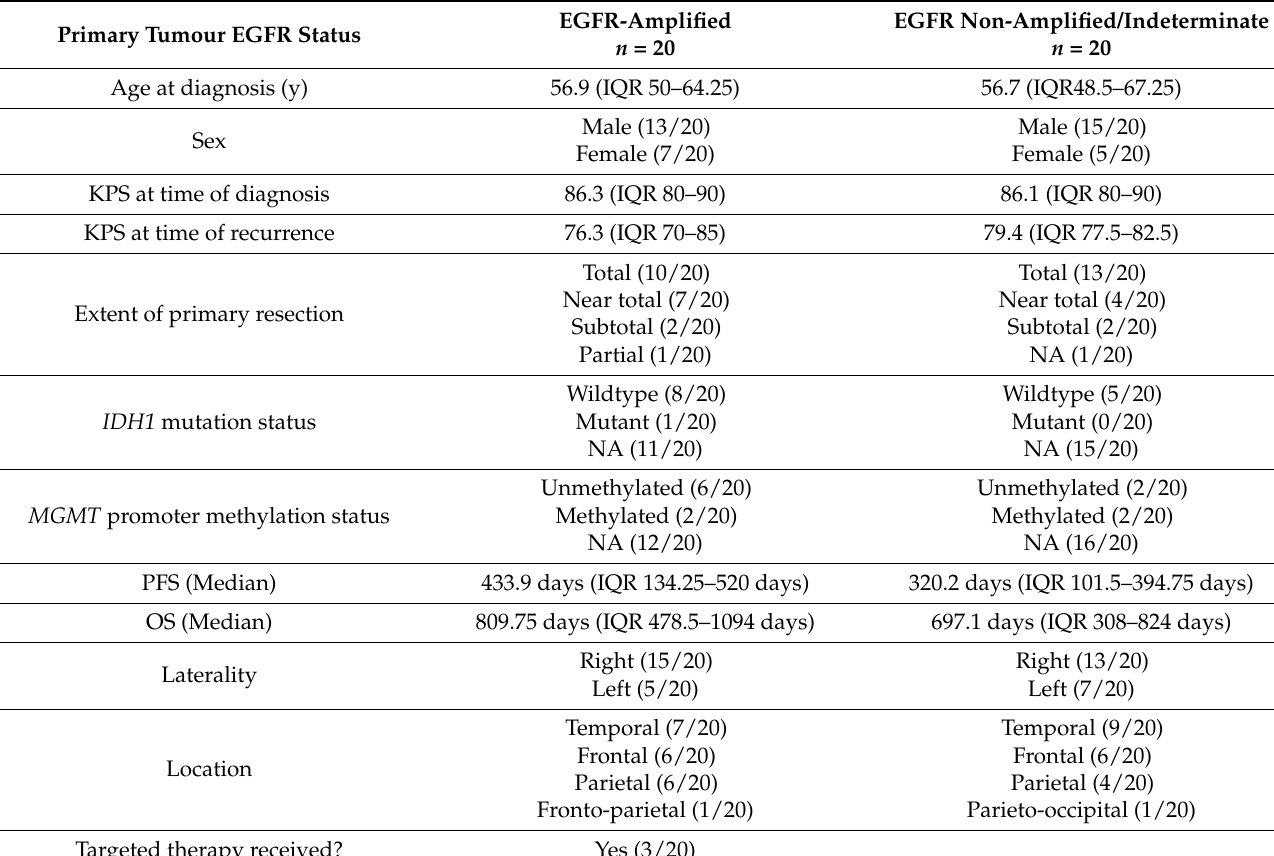
Table 1. Patient characteristics. Summary of patient characteristics for matched primary and recurrent tumour samples. IQR: interquartile range; KPS: Karnofsky performance status; NA: not available; PFS: progression free survival; OS: overall